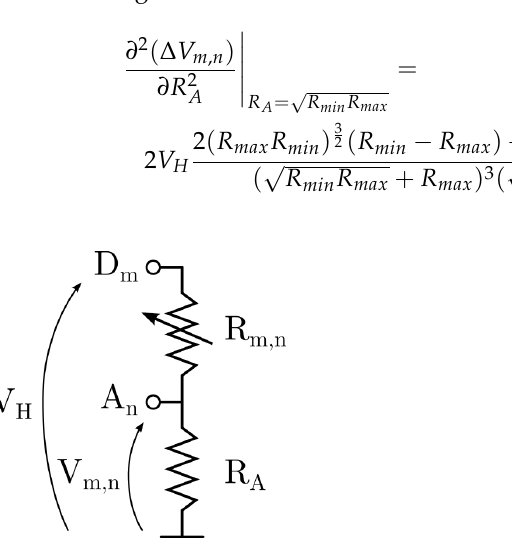
Figure A1. Schematic representation of a textile matrix